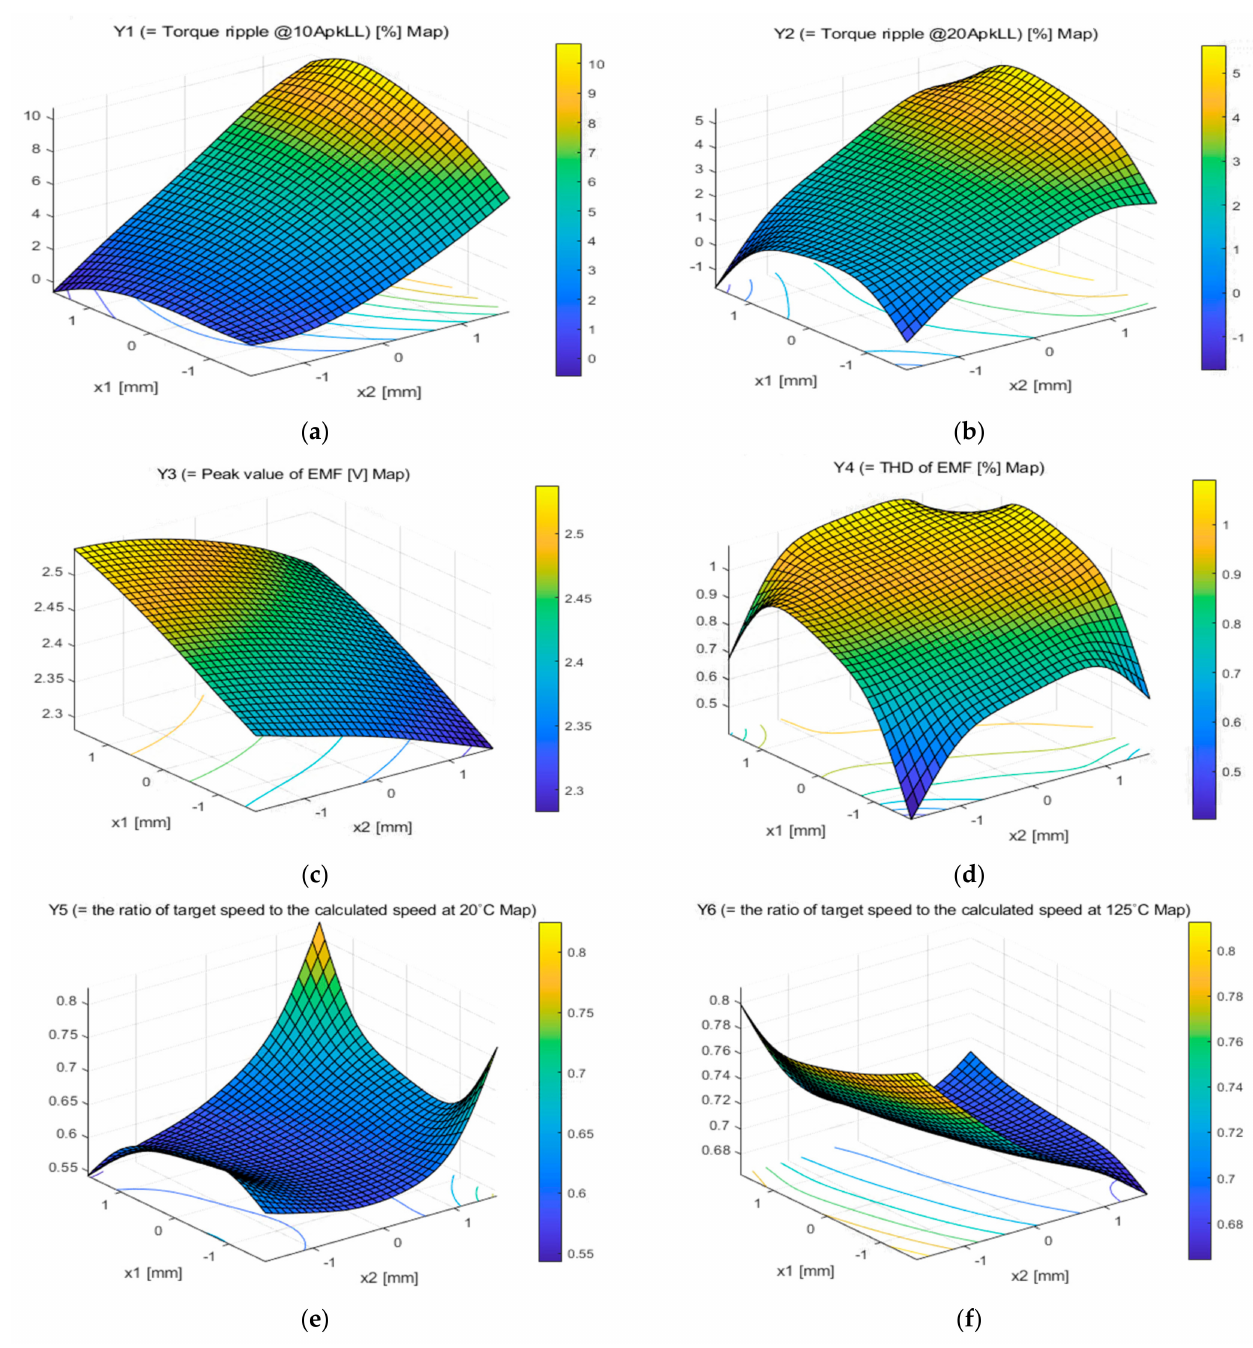
Figure 12. Response surfaces for objective functions at X3 = 0 (deg): ( a ) Y1; ( b ) Y2; ( c ) Y3; ( d ) Y4; ( e ) Y5; ( f )